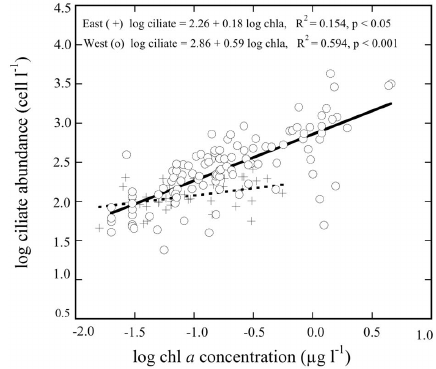
Fig. 15. Log–log linear regression between chl a concentration (µgl − 1 ) and ciliate abundance (celll − 1 ), taken at depths between 5 and 200m, for Western and Eastern Mediterranean